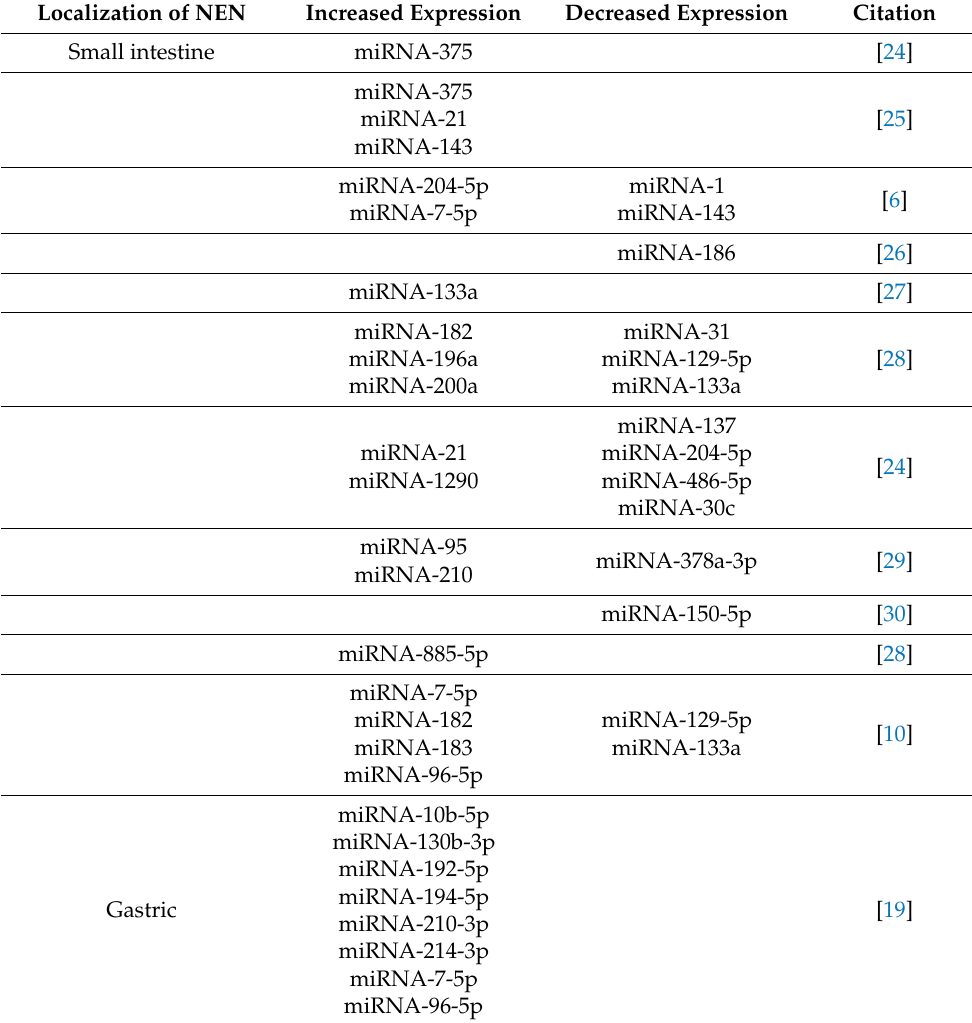
Table 1. Differentially expressed miRNAs at main NEN